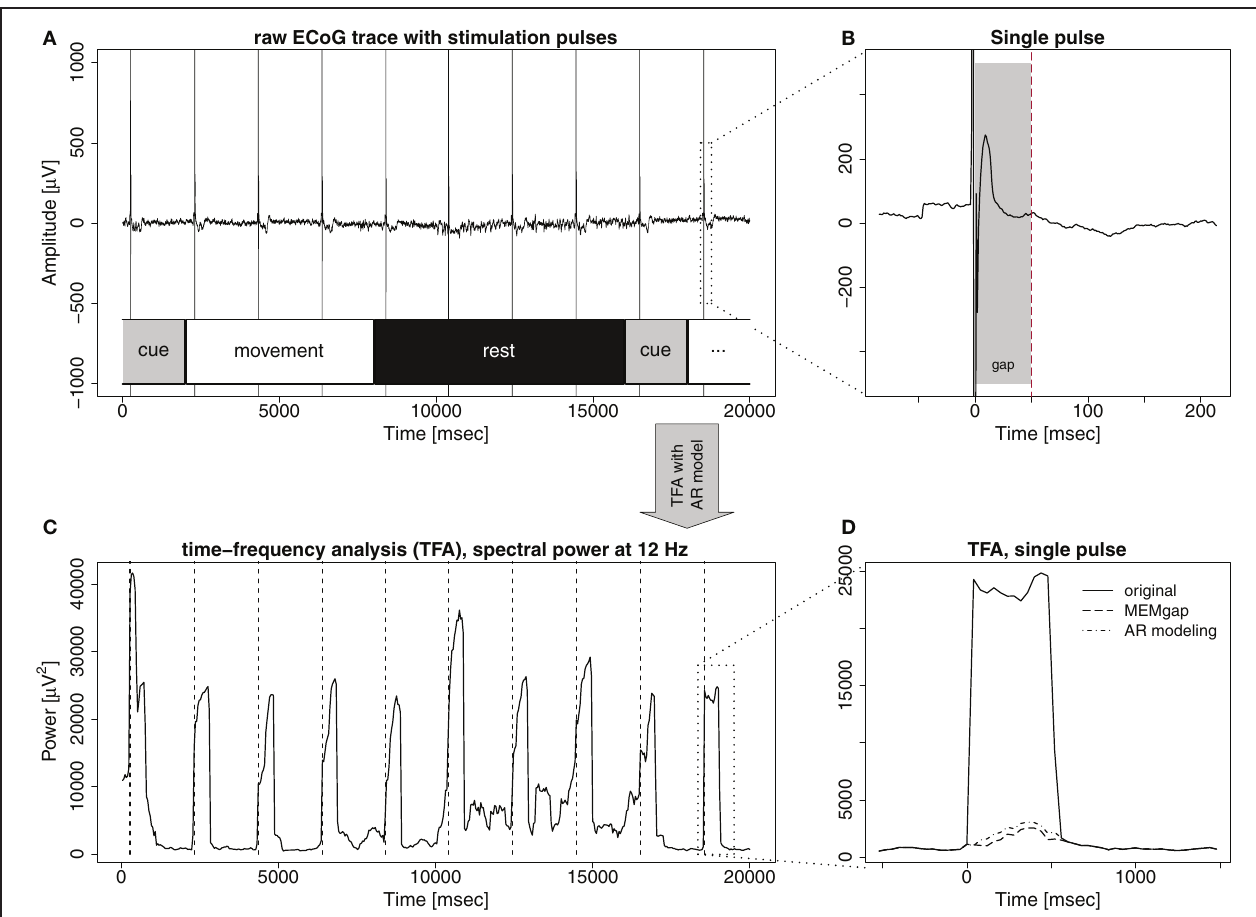
FIGURE 1 | The effect of stimulation pulses on time-frequency analysis (TFA) with AR models. (A) Example trace of ECoG data with intermittent stimulation pulses. Each pulse is visible as a sharp, strong artefact in the signal. The lower part of the illustrates the phases of the trial over the course of the recording: cue : an auditory cue, movement : patient attempts to move the hand, and rest : patient relaxes. (B) A zoom on the last stimulation pulse visible in (A) , also displaying an evoked potential, peaking 13ms after the pulse. If the gray-shaded area up to the dashed line is defined as a gap, both the stimulation artefact and the strongest evoked